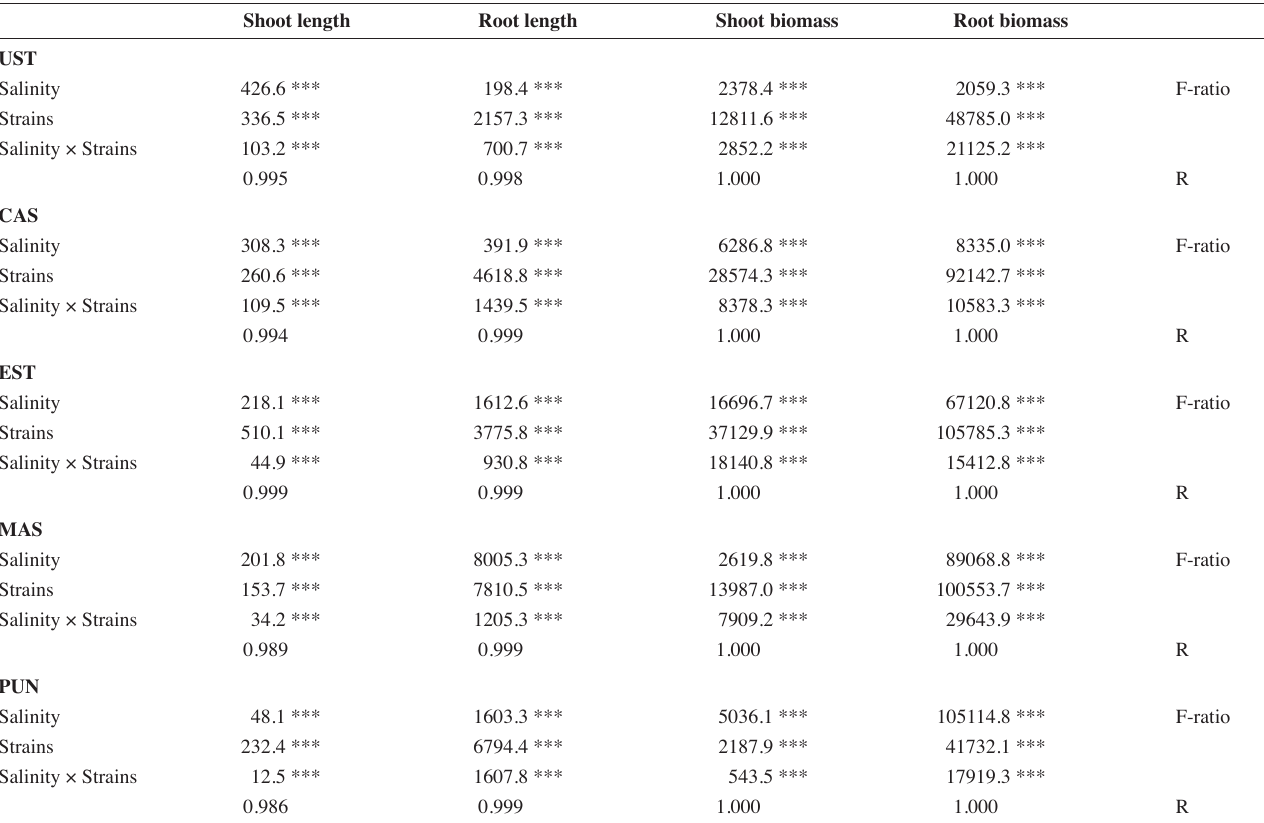
Tab. 3: Analysis of Variance of the effects of salinity and strains on shoot and root length (cm plant -1 ) and shoot and root biomass (mg plant -1 ) of Ustica (UST), Castelluccio (CAST), Eston (EST), Masoor 85 (MAS) and Punjab Masoor 2009 (PUN)